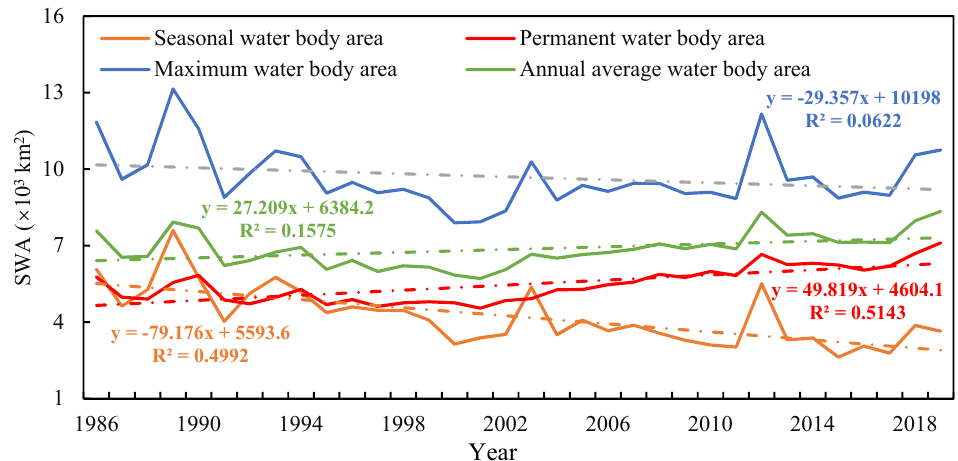
Figure 9. Continuous dynamic changes in the different types of water bodies—including the seasonal, permanent, maximum, and annual average water bodies—in the entire YRB during 1986–2019.